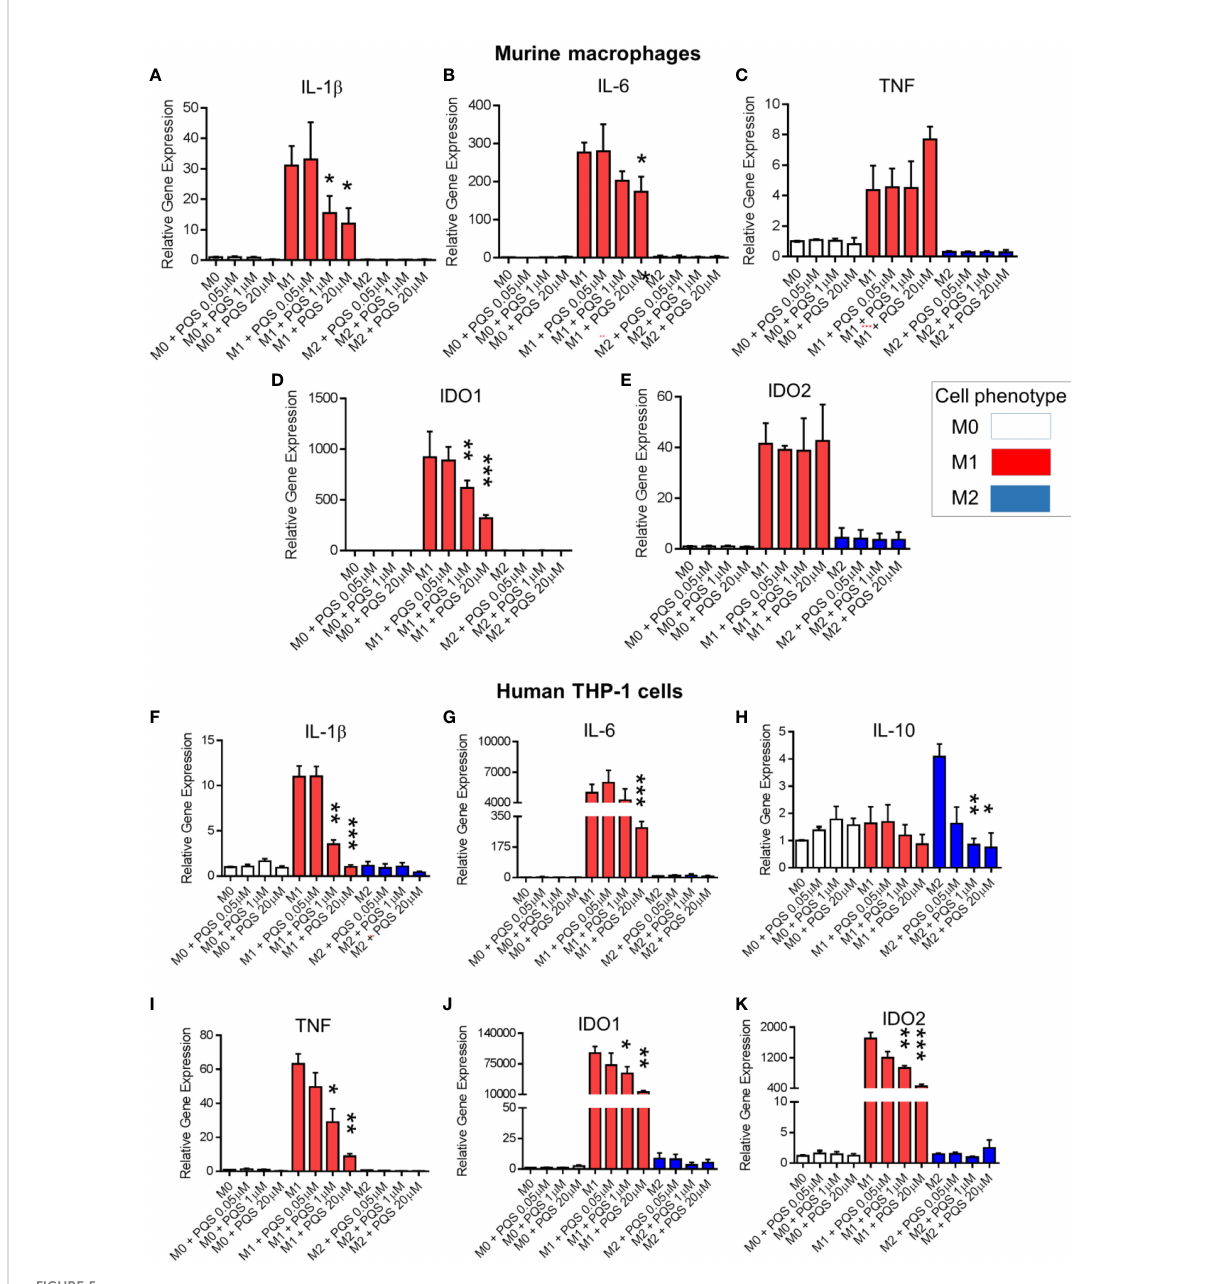
FIGURE 5 PQS reduces in fl ammation-associated gene expression in polarized macrophages. In murine bone marrow-derived macrophages the expressions of (A) IL-1 b , (B) IL-6, (C) TNF, (D) IDO1 and (E) IDO2 were measured after polarisation to M0, M1 and M2 macrophages in the presence of PQS (0.5-20 m M). In human THP-1-derived M0, M1 and M2 macrophages cultured in the presence of PQS, the expressions of (F)